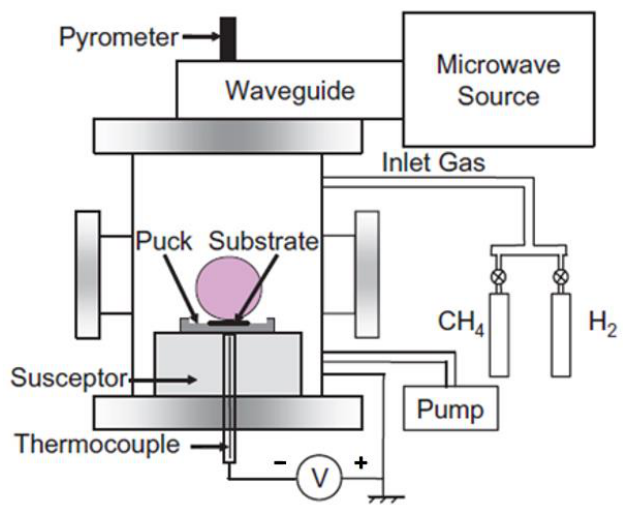
Figure 1. Schematic diagram of microwave plasma chemical vapor deposition device [20].